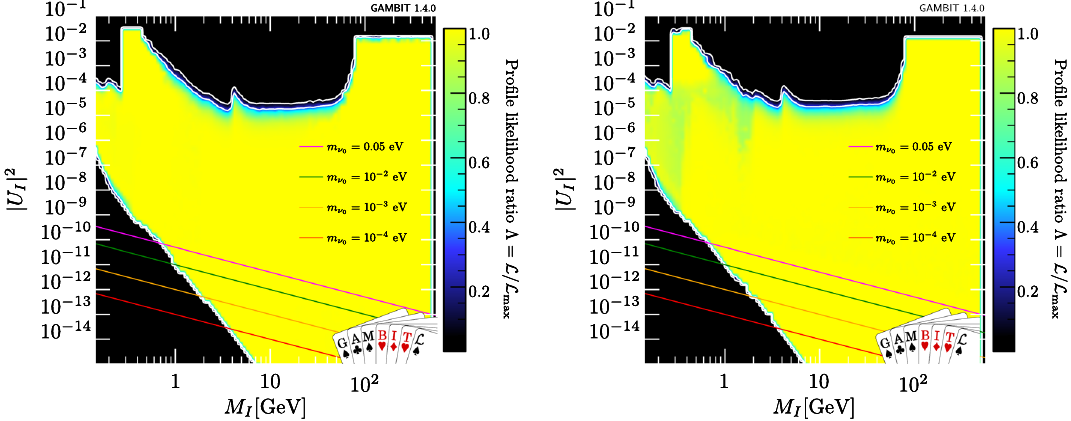
Fig. 4 Profile likelihood in M I vs U 2 plane for normal (left) and inverted hierarchy (right). Overlaid are the lowest limits for various values of I m ν [42]. Tables with the 90% and 95% CLs for both hierarchies can be found in Zenodo 0